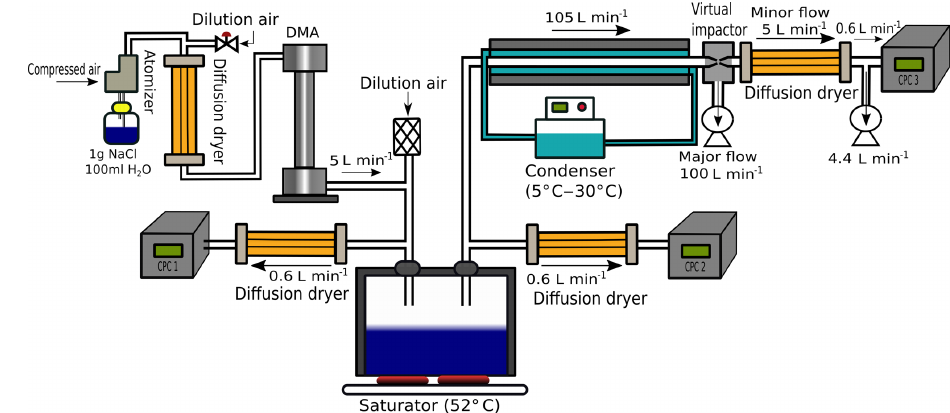
Figure 1. Set-up for the CCN-VACES calibration. Only one condenser tube is used for the